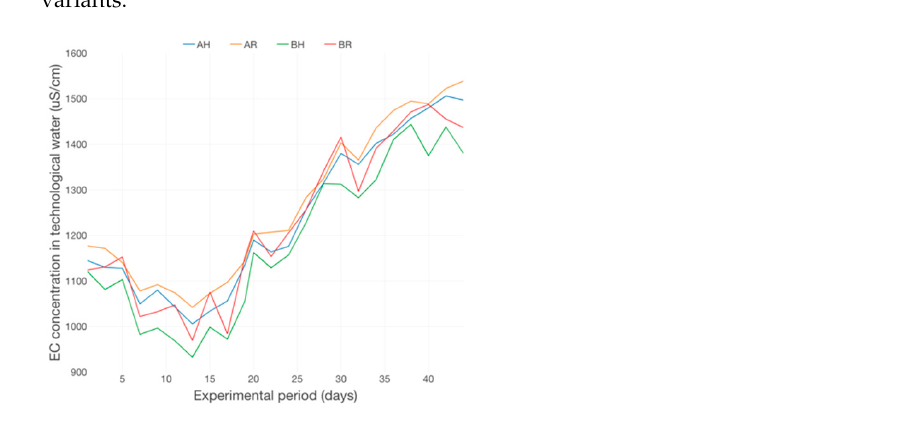
Figure 20. The dynamics of EC concentration in technological water for each of the experimental variants.